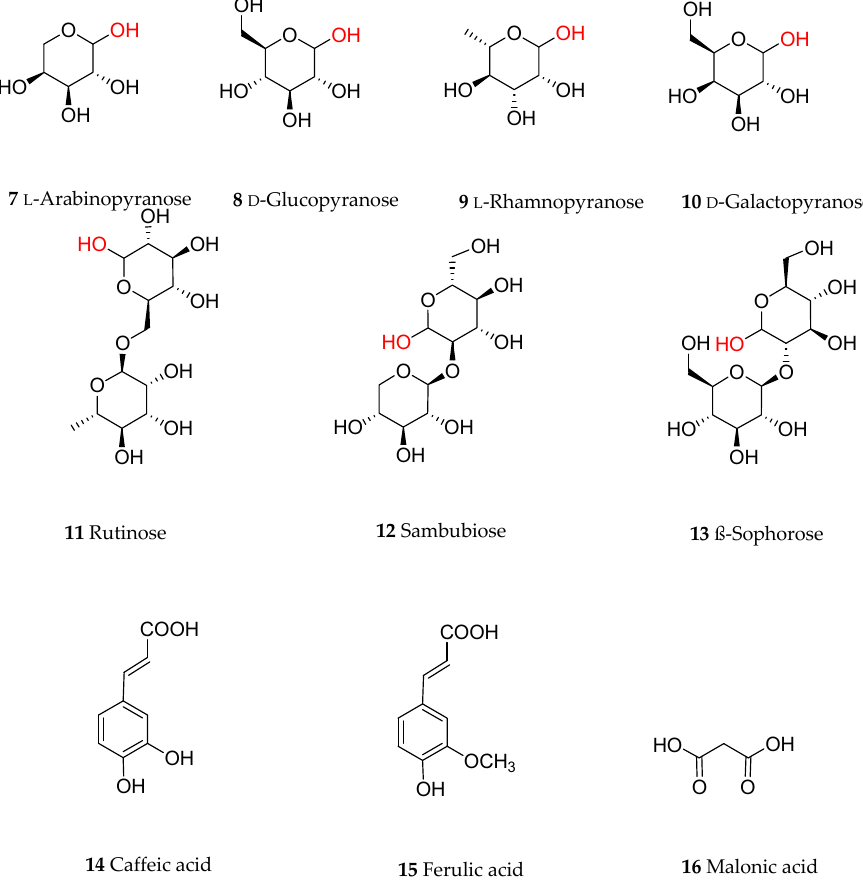
Figure 2. Common sugars and ester derivatives of anthocyanins discussed in this article. The linking position of the sugars with the flavonoid skeleton is shown in red.